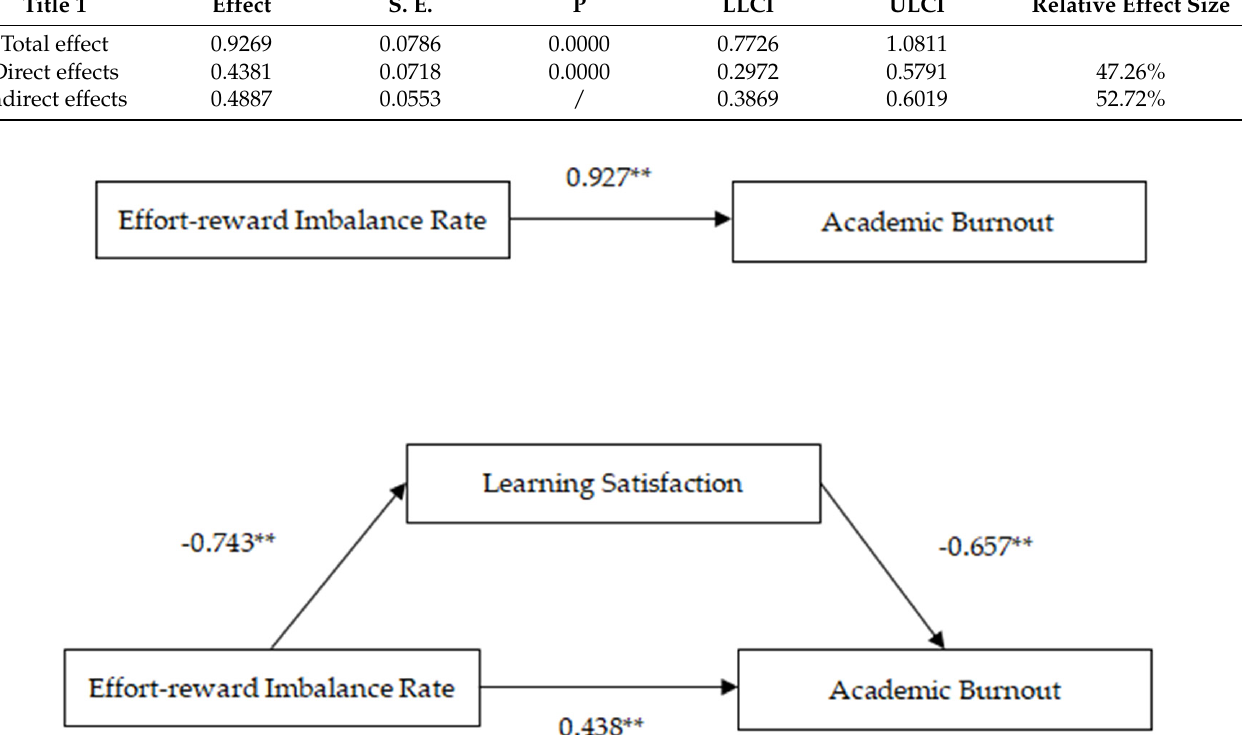
Figure 2. Mediating model of learning satisfaction, ** indicates p < 0.01.